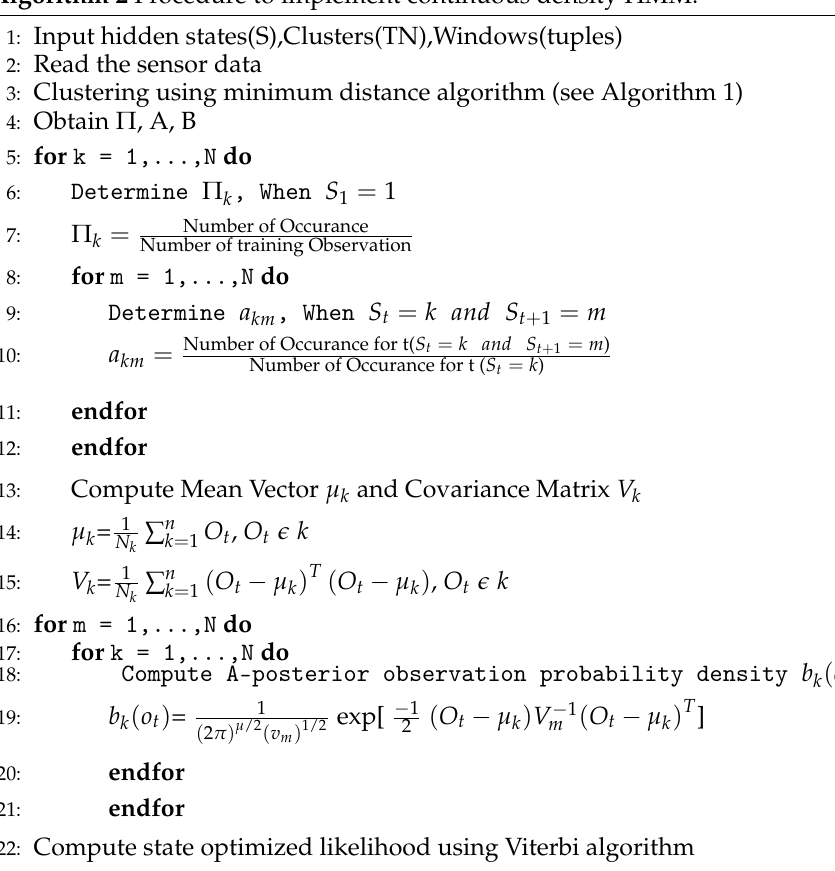
Algorithm 2 Procedure to implement continuous density